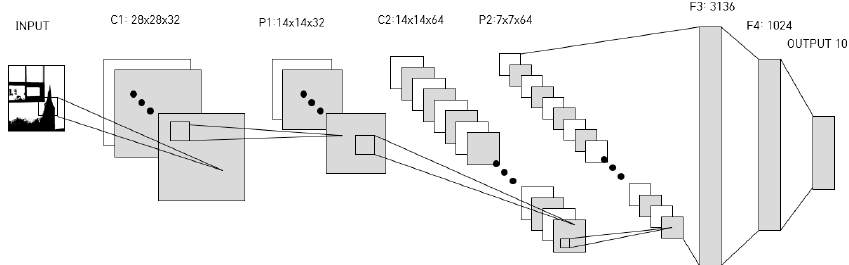
Figure 10. Architecture of extended CNN.